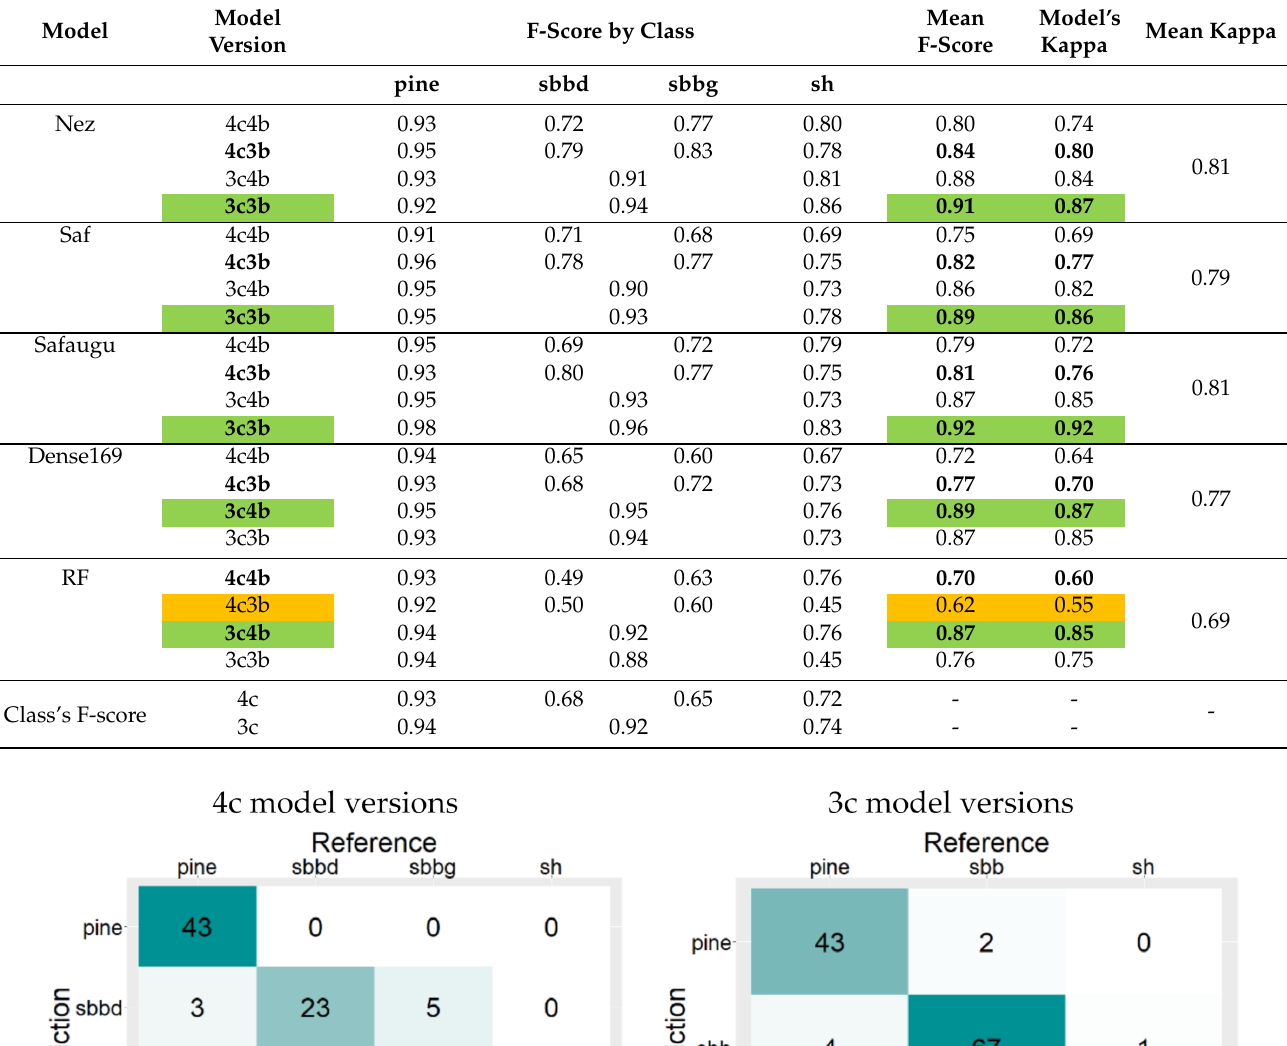
Table 6. Evaluation metrics of bark beetle disturbance classification at the tree level. For the pair of models of the same architecture and the same number of output classes but the different number of input bands, the more accurate model is highlighted in bold. For each model, the most accurate model version is highlighted in green. The model showing the general poorest performance is highlighted in orange.